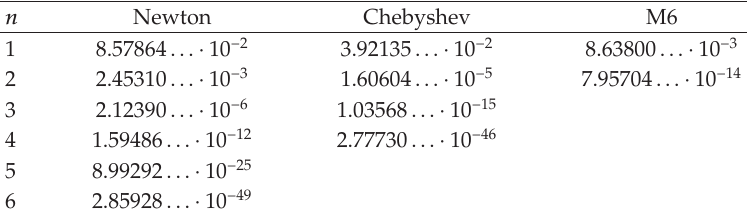
Table 2: The computational order of convergence for the Newton, Chebyshev and M6 methods. n ρ N ρ CH ρ M6